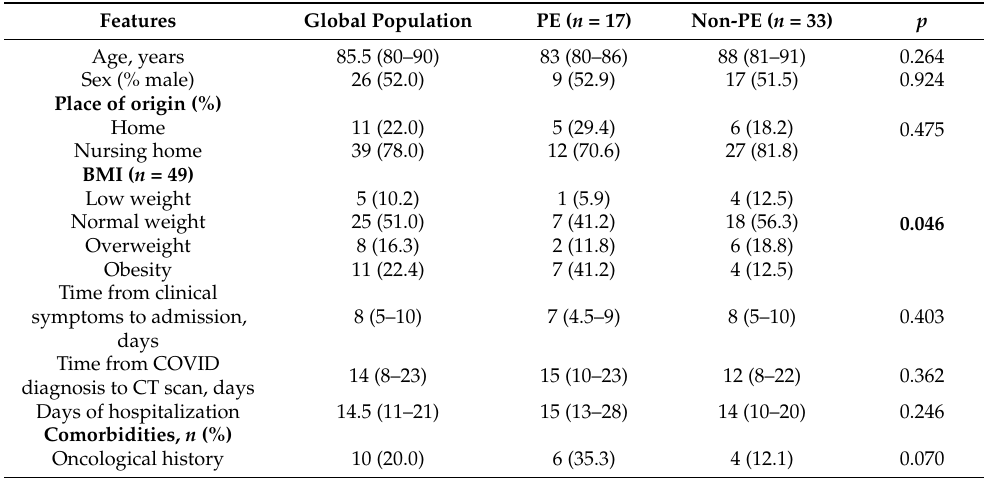
Table 1. Characteristics of the